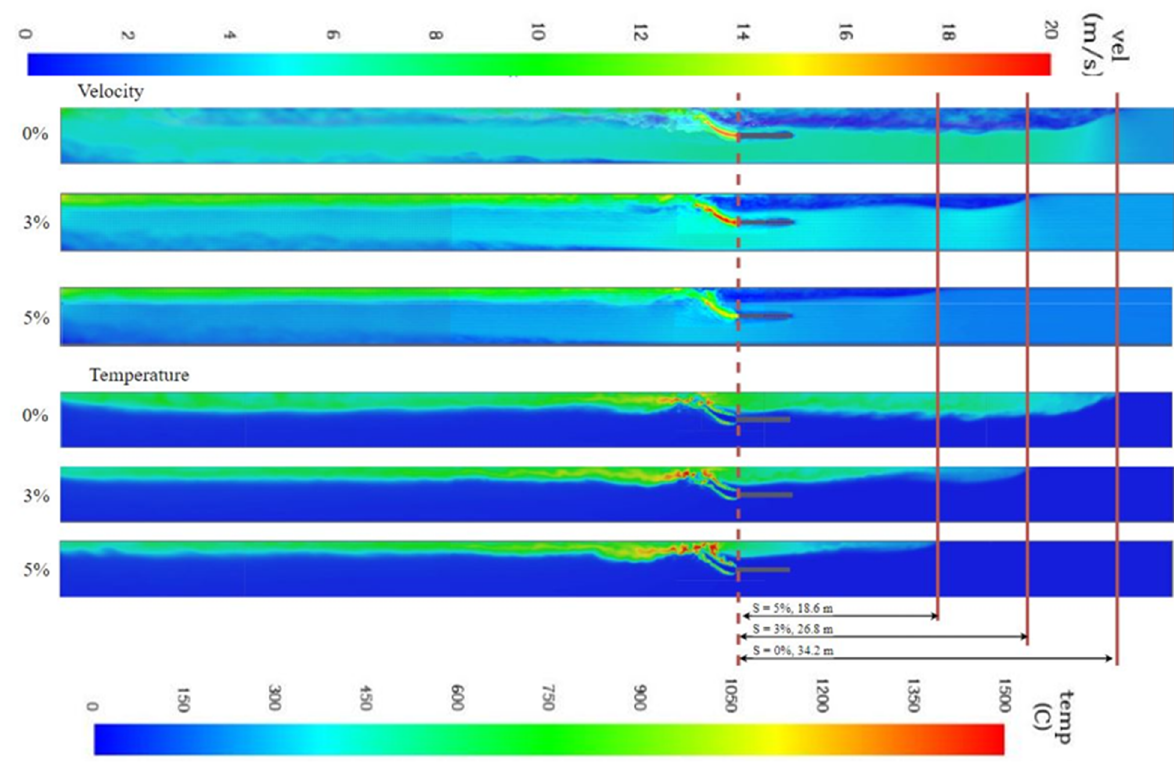
Figure 7. 2D temperature and velocity contour plots at 45 s–effect of tunnel slope (Cases 2,8, and